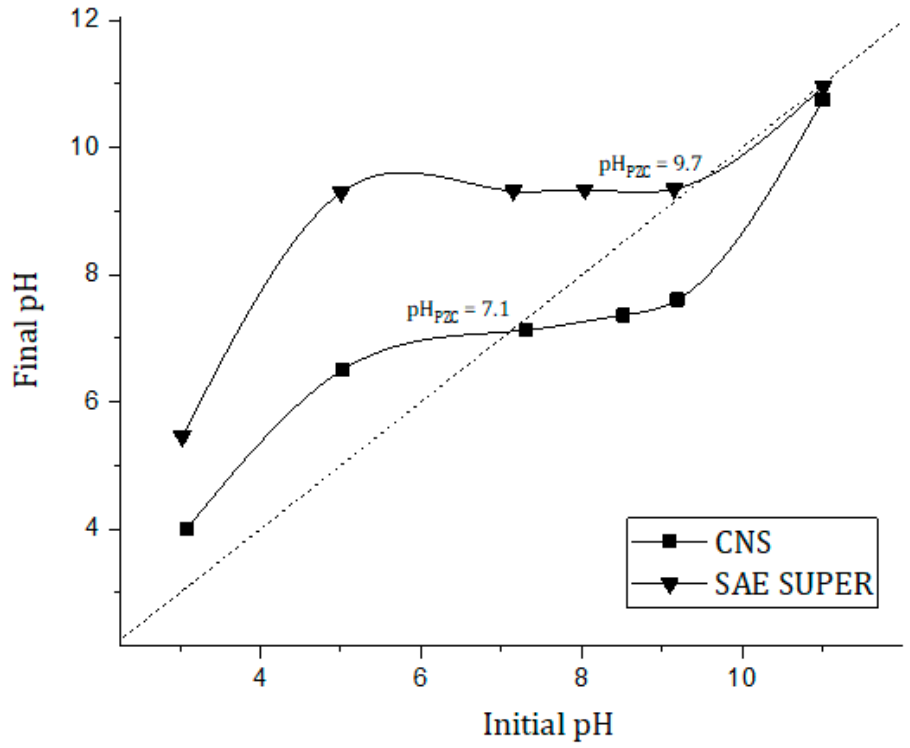
Figure 3. pH drift method plot to determine the pH PZC for CNS and SAE SUPER-activated carbon.